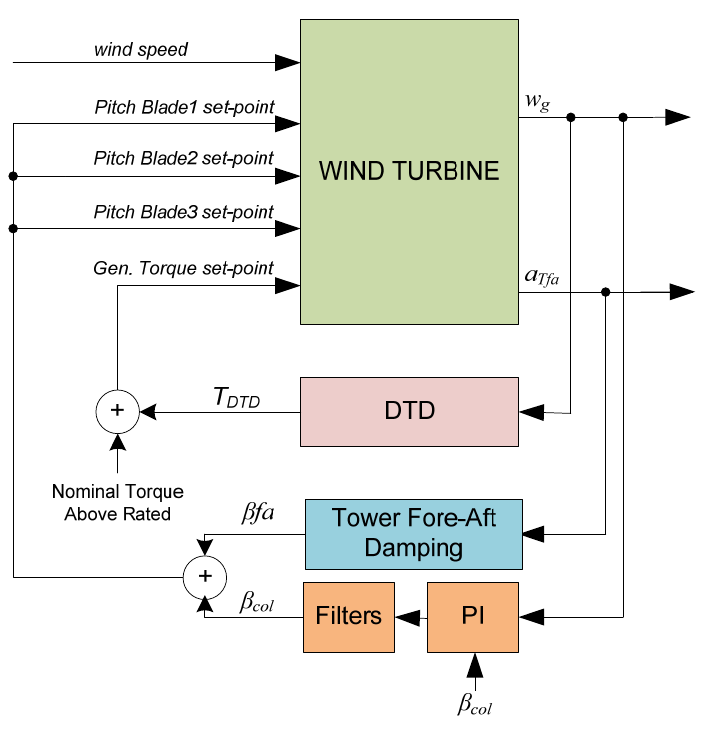
Figure 3. Baseline C1 control